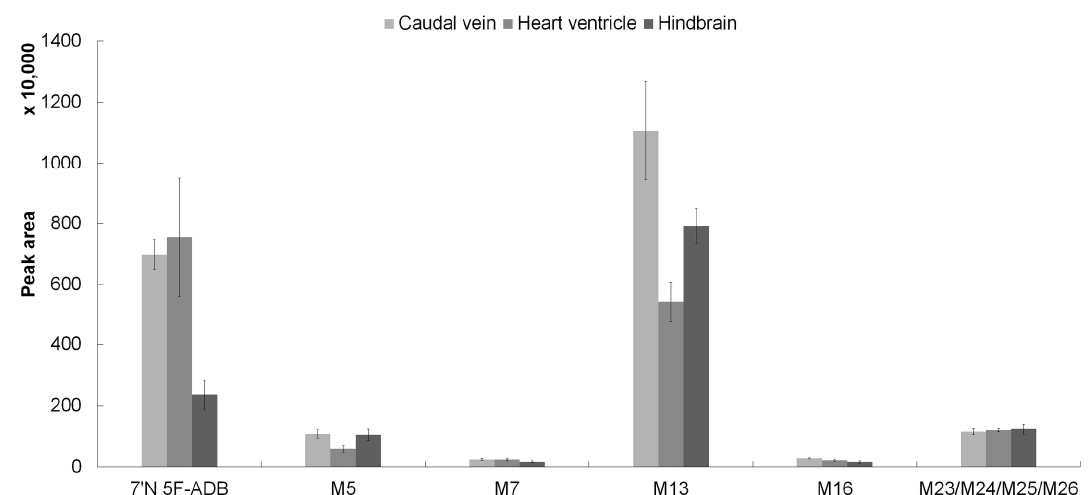
Figure 4. Detection profile of 7′ N -5F-ADB and five major metabolites in microinjected ZF larvae (caudal vein, heart ventricle, and hindbrain). The most abundant metabolite, M13, was formed by defluorination in combination with oxidation of the formed primary alcohol (M7) to a carboxylic acid moiety. The clustered columns are displayed as mean ± SD ( n = 3). The four structural isomers (M23, M24, M25, and M26) at m / z 410.2075 are represented as one metabolite due to co-elution from the LC-HRMS / MS system.